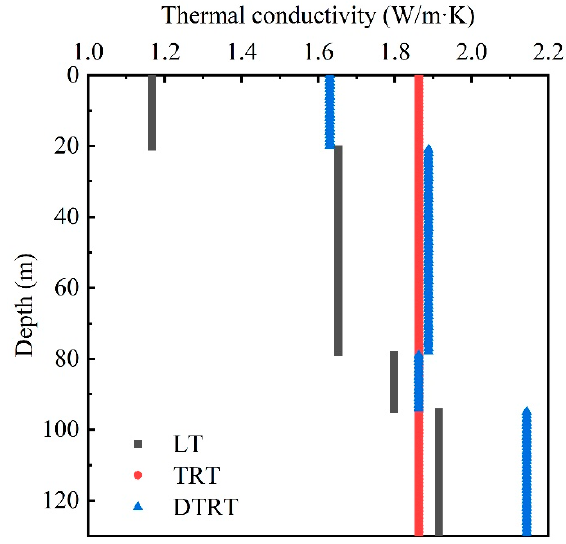
Figure 9. Average thermal conductivity obtained by three test methods.